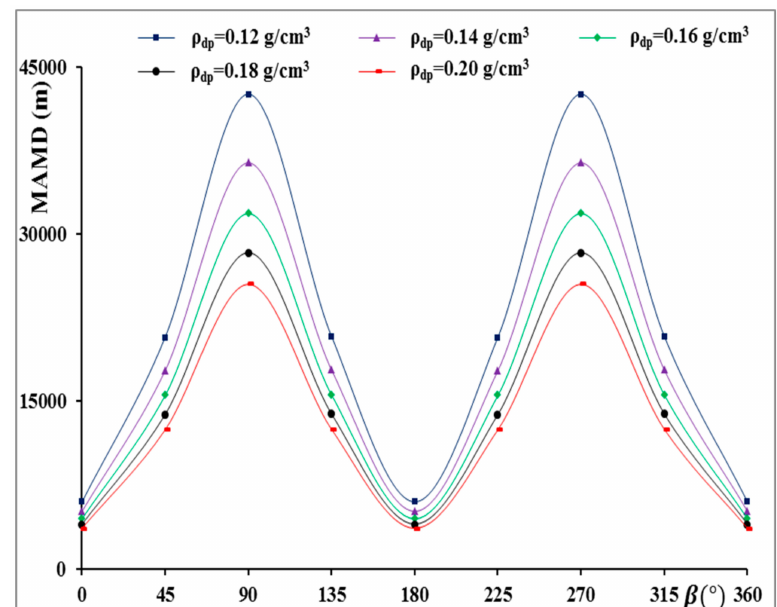
Figure 5. MAMD with ∆ p p / p p =